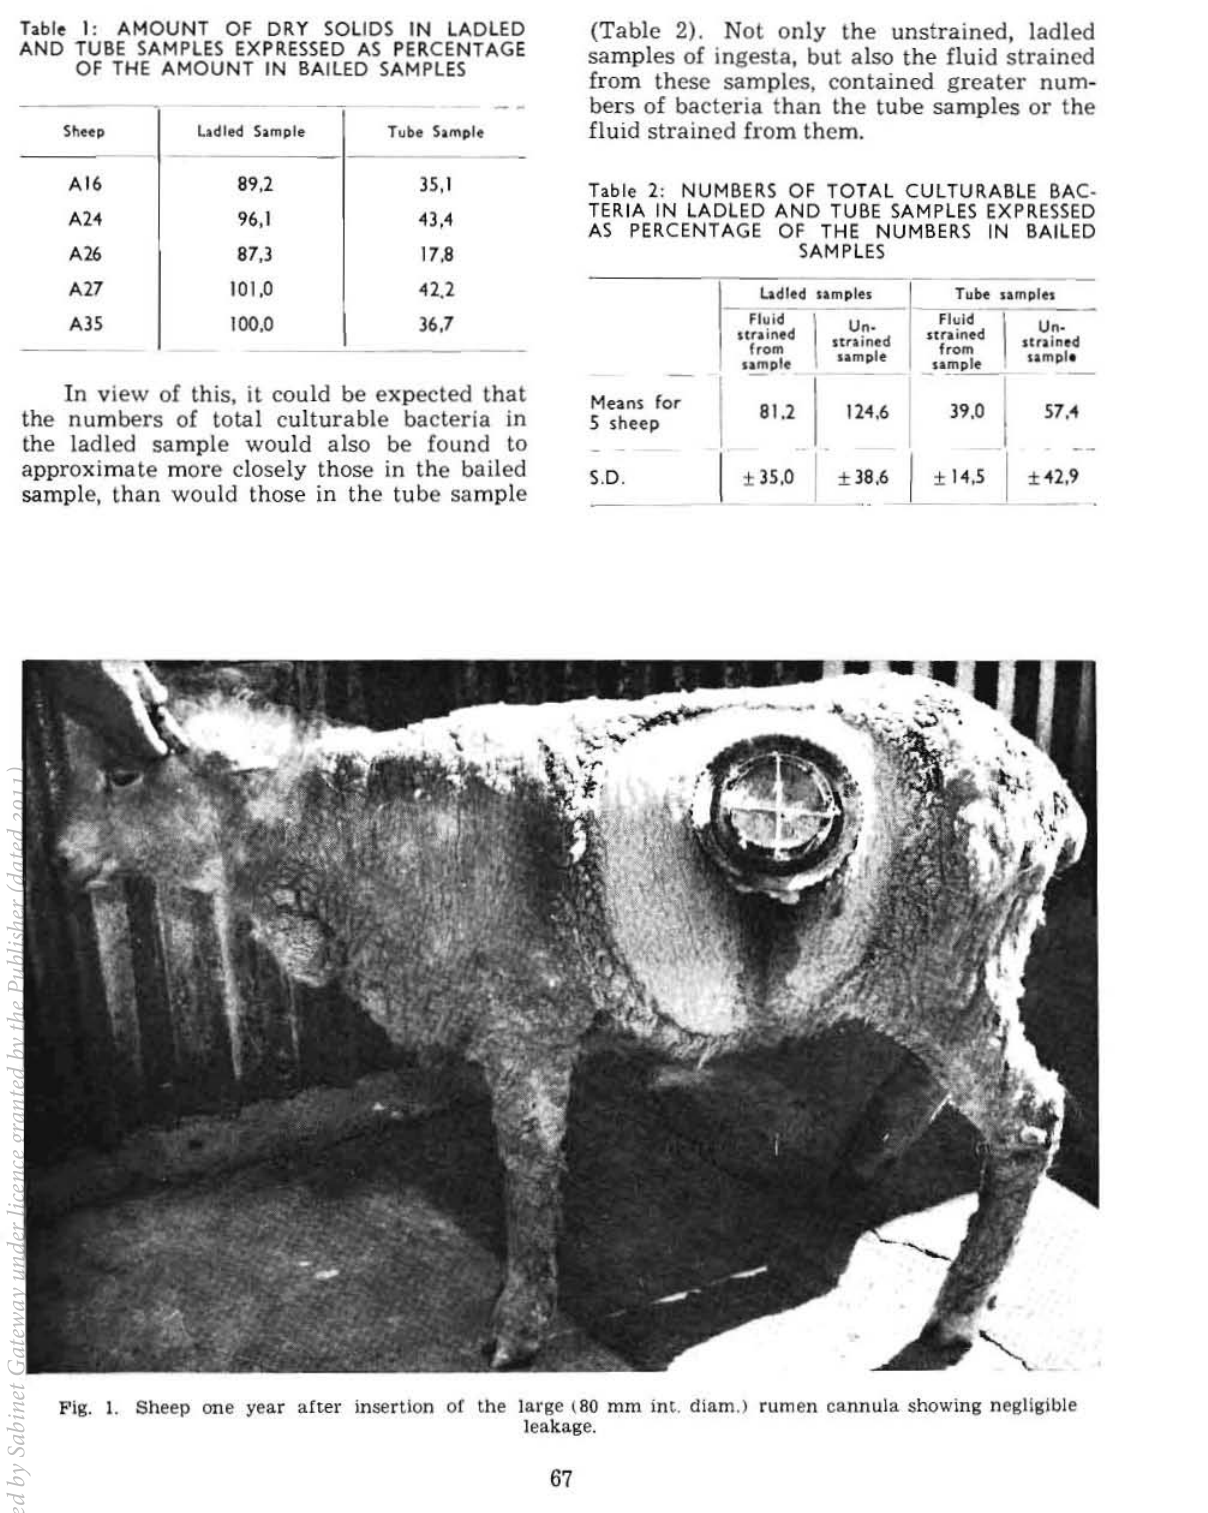
Fig. I. Sheep one year after insertion or the large (80 mm into dlam.) rumen cannula showing negligible